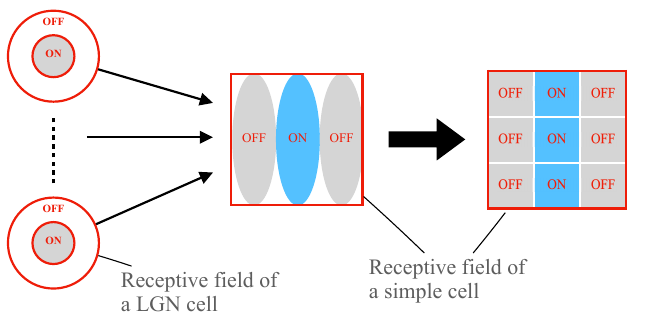
Figure 5. The formation of a simple cell receptive field by linking several LGN cell receptive fields.